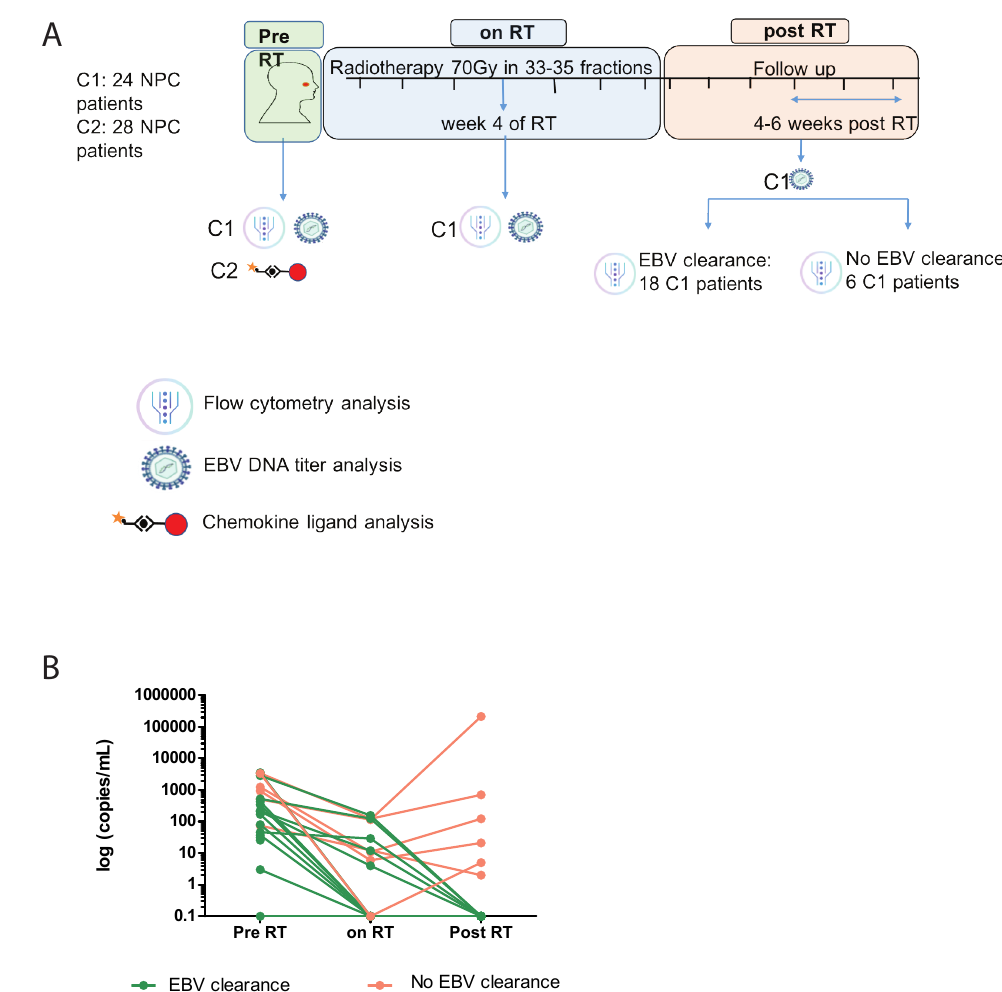
Figure 1. Study design of NPC treatment, collection of biomaterials and detection of plasma EBV DNA and T-cell profiling. ( A ) Schematic diagram of NPC patient Cohorts 1 and 2, timeline of Figure 1: Study design of NPC treatment, collection of biomaterials and detection of EBV DNA and T cell profiling. radiotherapy, collection of biospecimens and readouts. Patients diagnosed with NPC received 7 weeks of radiotherapy (RT) with or without chemotherapy. Whole blood was collected to isolate PBMCs as well as plasma. The latter was used to calculate EBV DNA titers or chemokine ligand levels. Epstein–Barr virus DNA titers were measured at pre-RT, at week 4 during RT (on-RT) and between 4 and 6 weeks after RT (post-RT). Peripheral blood mononuclear cells were used for flow cytometry analysis of T-cell subsets according to >20 markers of maturation, co-signaling and chemotaxis. Plasma EBV DNA titers at post-RT were used to stratify patients as those who cleared or did not clear EBV DNA. See Materials and Methods for details. ( B ) Line plots showing plasma EBV DNA titers of NPC patients at all time points. Patients who did or did not clear plasma EBV DNA are indicated with green or red,